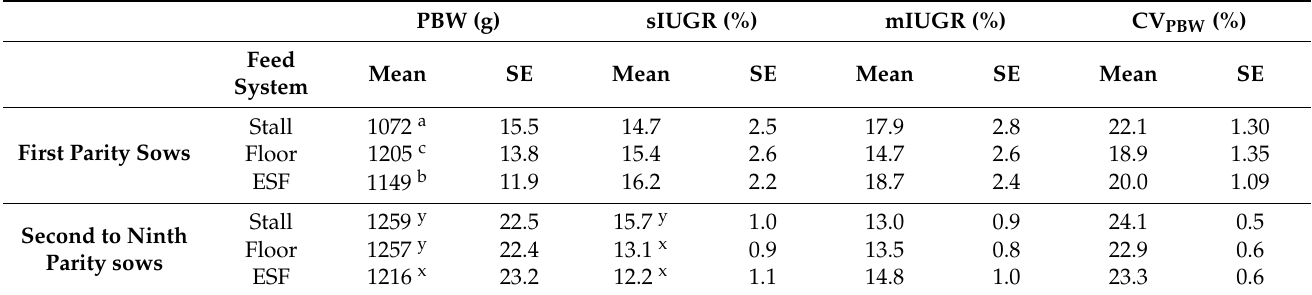
Table 4. LSmeans of piglet birth weight (PBW), within-litter proportion of severe IUGR (sIUGR) and mild IUGR (mIUGR) piglets and within-litter variation in PBW (CV PBW ) of the different feed systems for sows of 1st and 2nd to 9th parity. Stall describes free-access feeding stalls, Floor describes floor feeding and ESF describes electronic sow